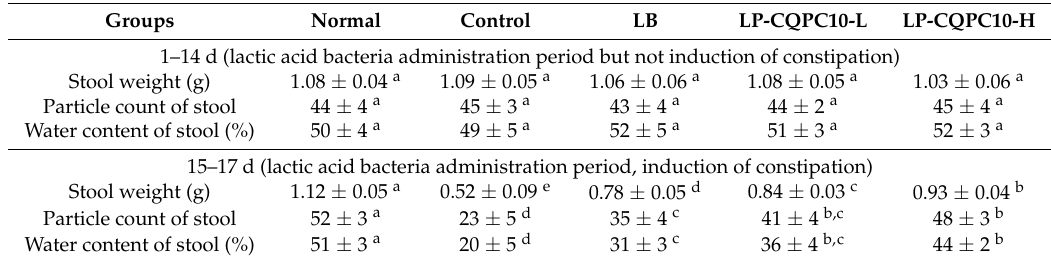
Table 3. Stool status of mice treated with soybean milk during the experiment. 44 ± 4 a Groups Normal Control LB LP-CQPC10-L LP-CQPC10-H